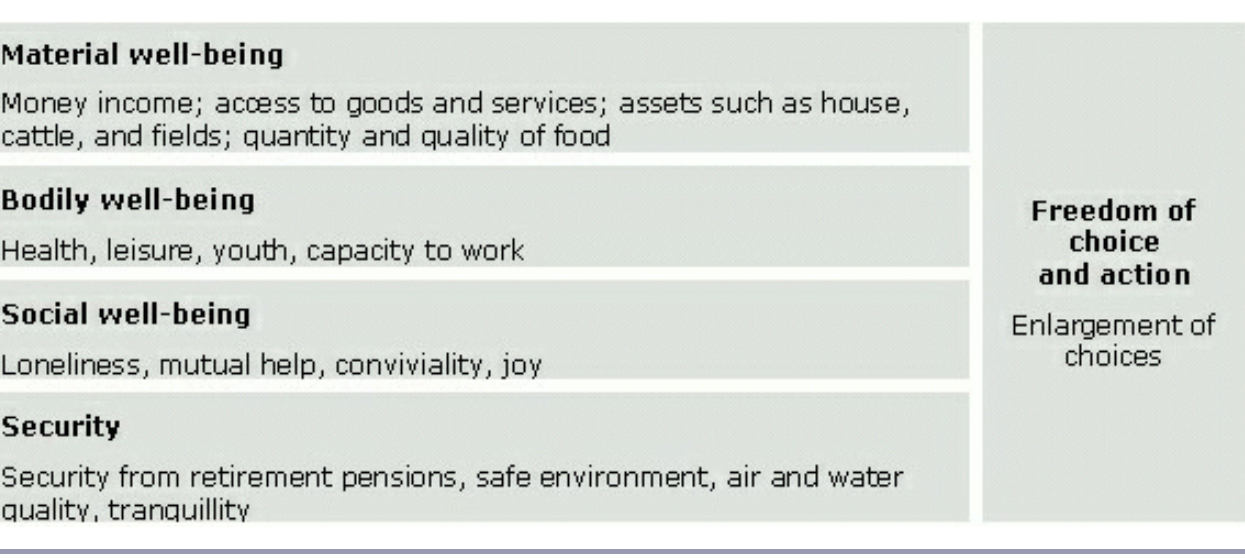
Fig. 5 . The criteria for human well-being most often cited by the participants in the areas identified by the Millennium Ecosystem Assessment. The criteria on the left all feed into freedom of choice and